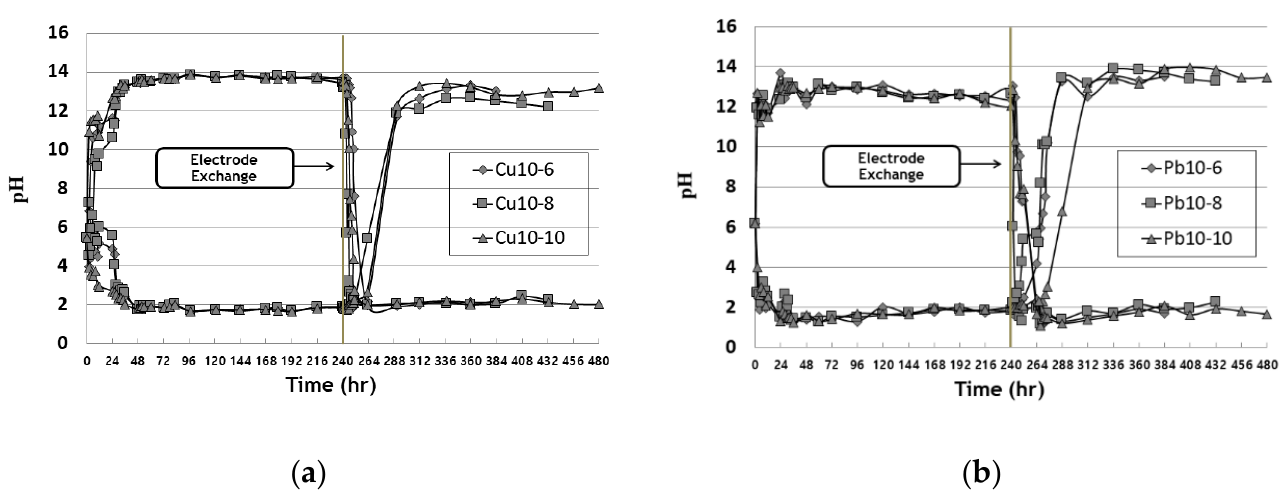
Figure 4. pH change of water tank during EK experiments: ( a ) copper; ( b ) lead.